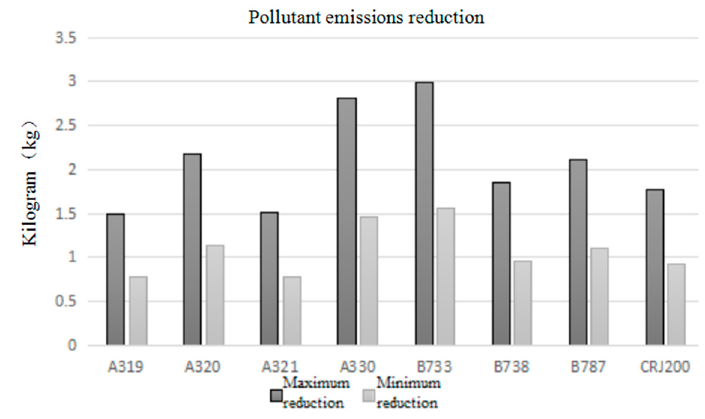
Figure 9. The reduction in the pollutant emissions.